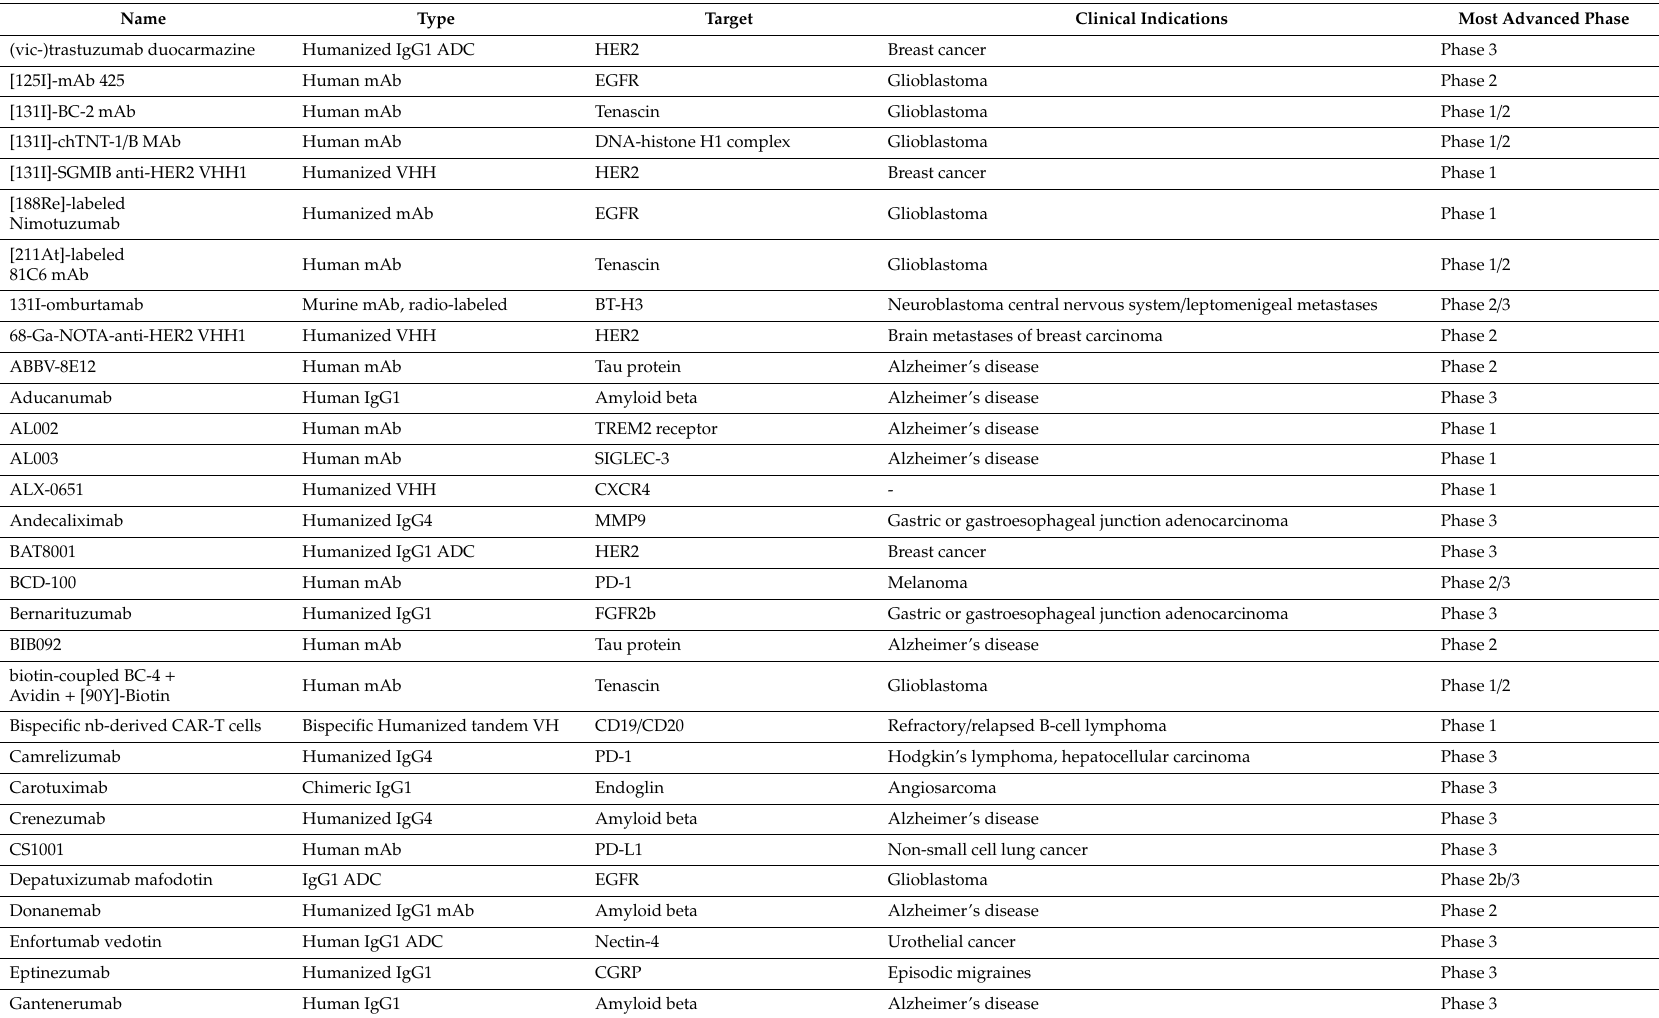
Table 2. Antibody therapeutics that are in investigation for cancer or central-nervous-system (CNS)